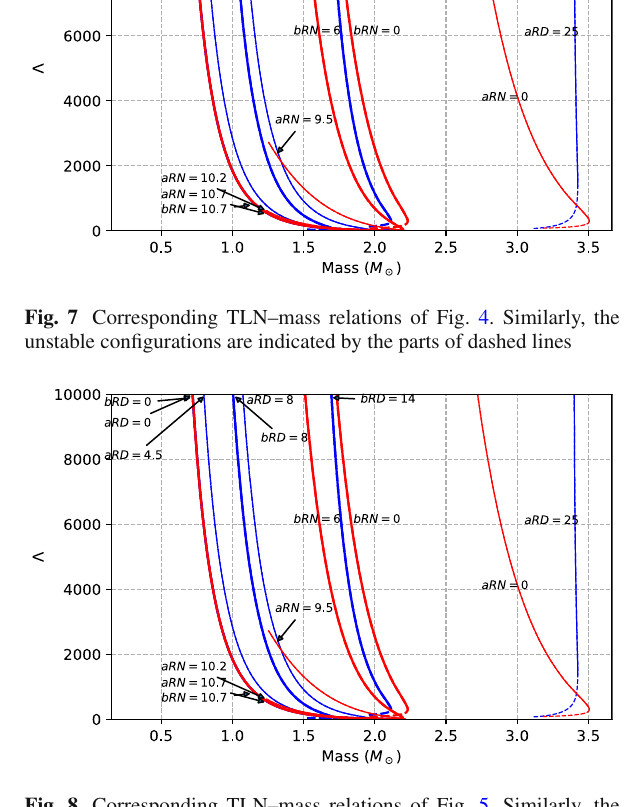
Fig. 8 Corresponding TLN–mass relations of Fig. 5. Similarly, the unstable configurations are indicated by the parts of dashed lines